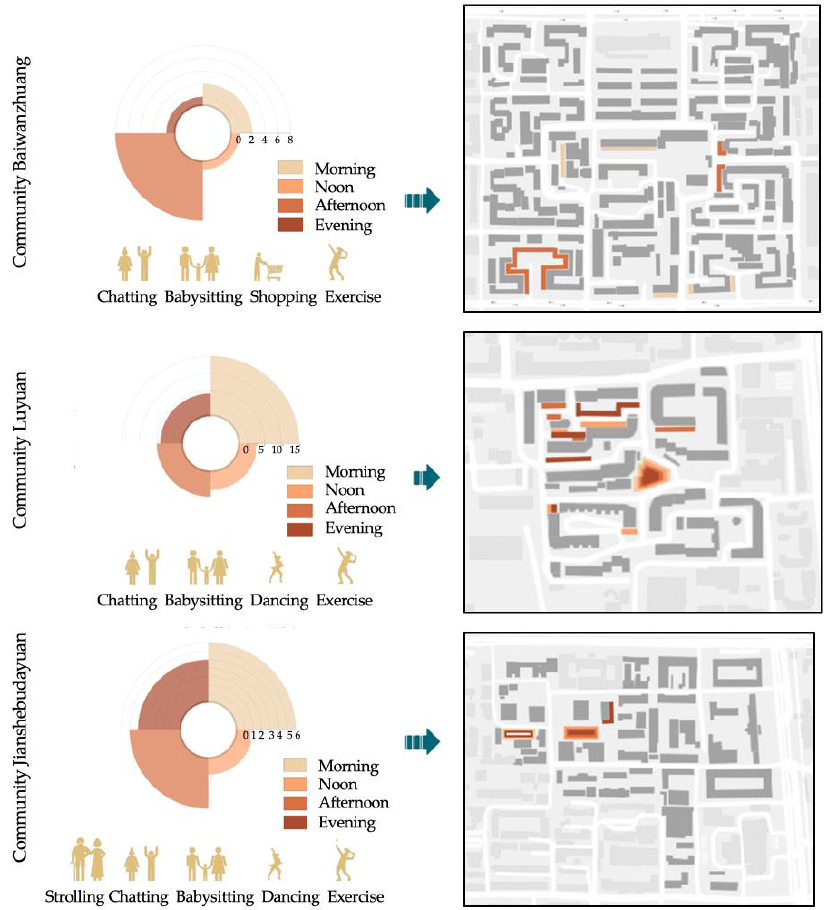
Figure 5. Social interaction among elderly women and public space sites.